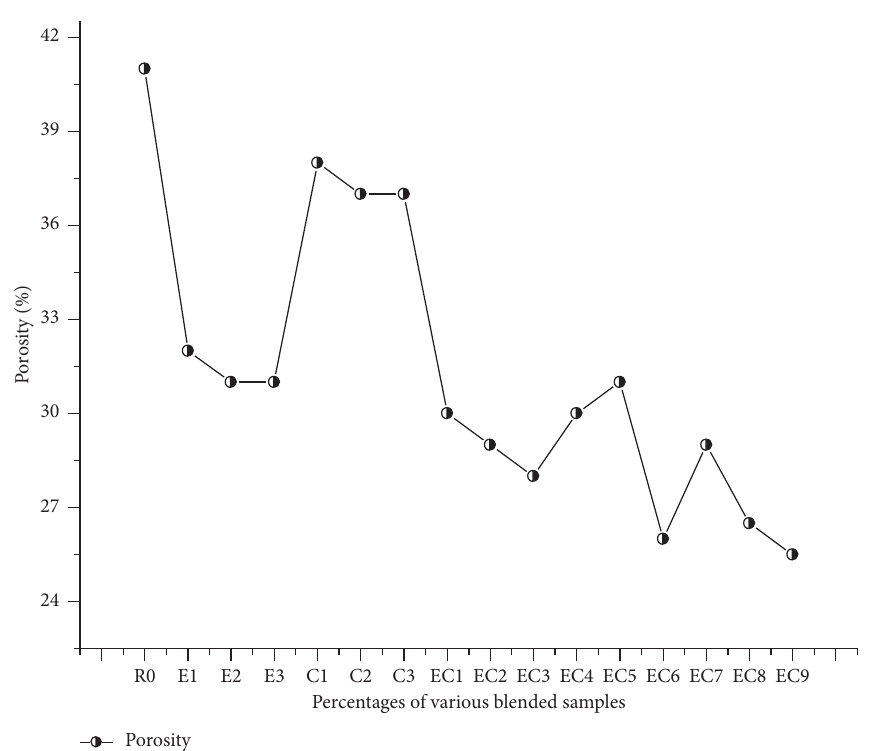
Figure 10: Porosity of soil mixtures with the incorporation of various percentages of cement and